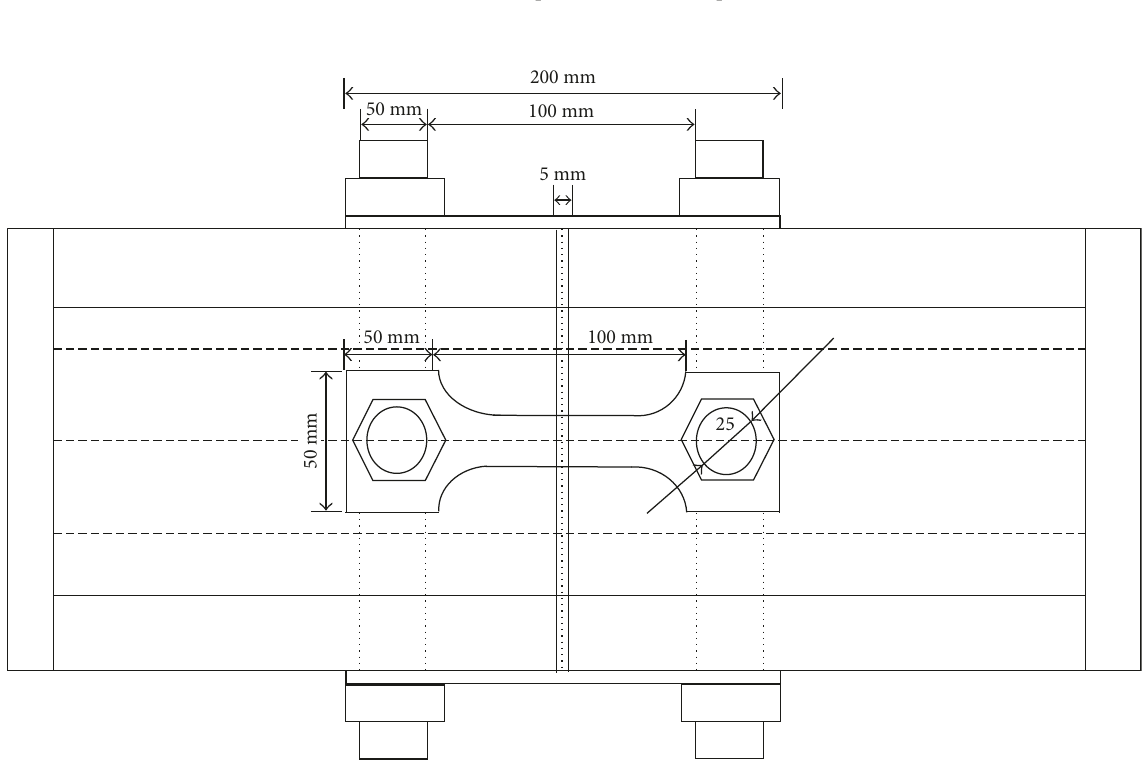
Figure 6: Detailed sizes of experimental